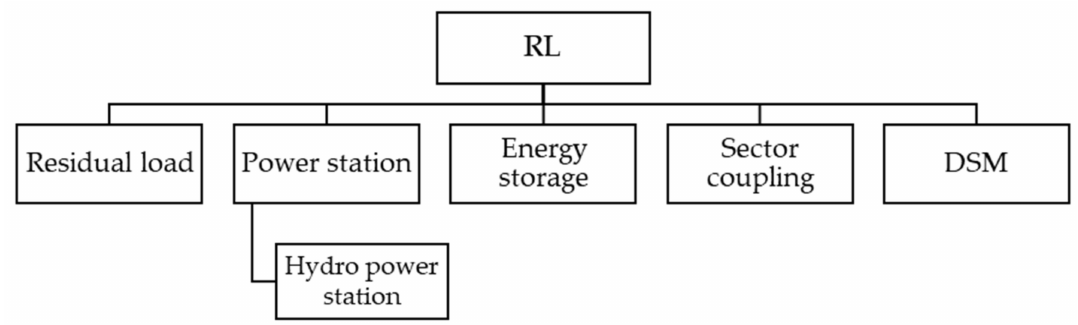
Figure 4. RL class and inherited